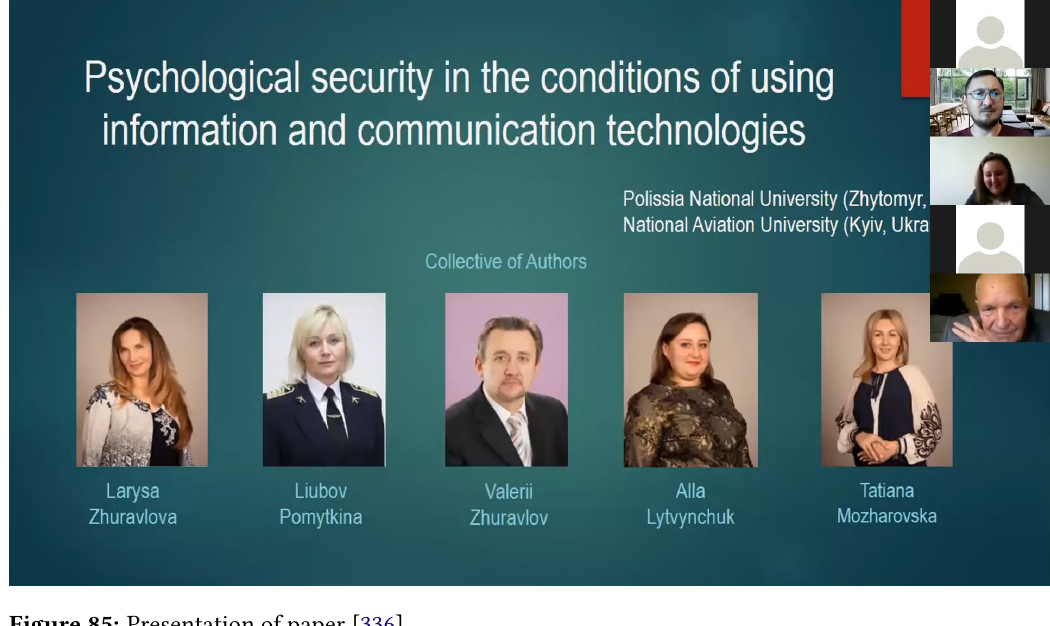
Figure 85: Presentation of paper [336].